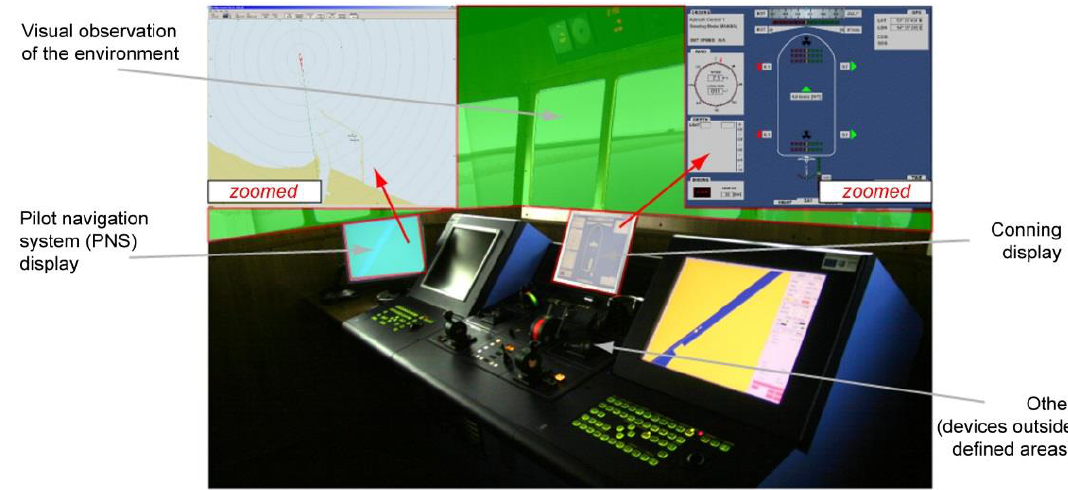
Figure 4. The location of areas of interest (AoIs) identified for the preliminary experiment.